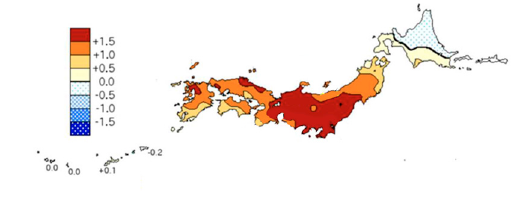
( a ) Difference between mean air temperature in 2018 and normal year.